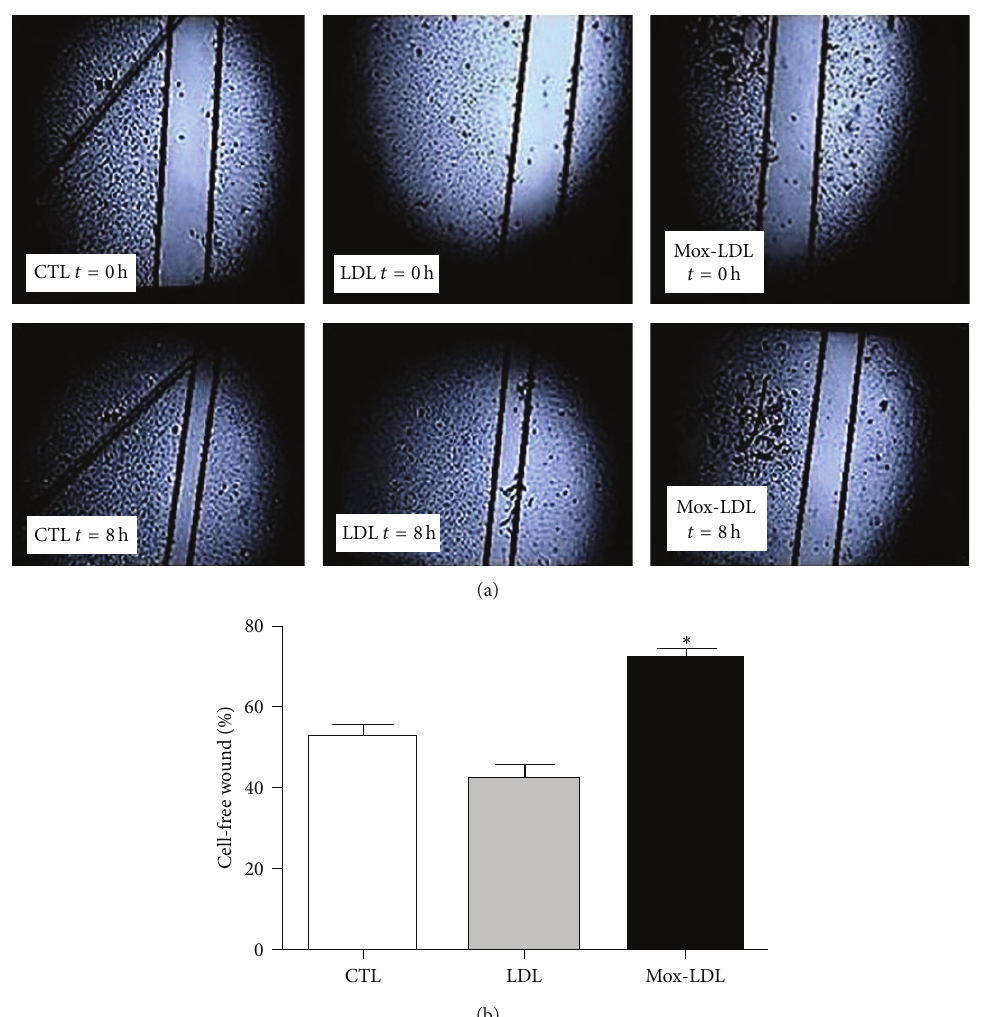
Figure 3: The effect of Mox-LDL treatment on wound closure after HUVEC monolayer scratch. (a) Scratched monolayers of HUVEC cells. HUVECwereseeded, allowed toreach confluence, andincubated for24 hoursmore. HUVECsweretheneither treatedornotwith nativeLDL or Mox-LDL for 24 h. Wounds were then made by scratching the confluent cell monolayers with a yellow pipet tip and washed twice and cells were incubated for additional 8 hours in the same conditions. Pictures were taken at time of wounding and eight hours later in all conditions. Black lines defining wound edges were superimposed to the pictures. The results shown are representative of three independent experiments performed in duplicate. (b) Quantification of (a). After scratching the HUVEC monolayers to induce wounds, cells were incubated for additional 8 hours in the above conditions, pictures were taken, and the distance between the wound edges were measured in all conditions. The distance that remained cell-free at 𝑡 = 8 h was calculated as a percentage of the initial wound width at time of scratching 𝑡 = 0 h. Mean ± SEM on 3 independent experiments performed in duplicate. ∗ 𝑃 < 0.05 versus control (ANOVA, Turkey’s multiple comparison